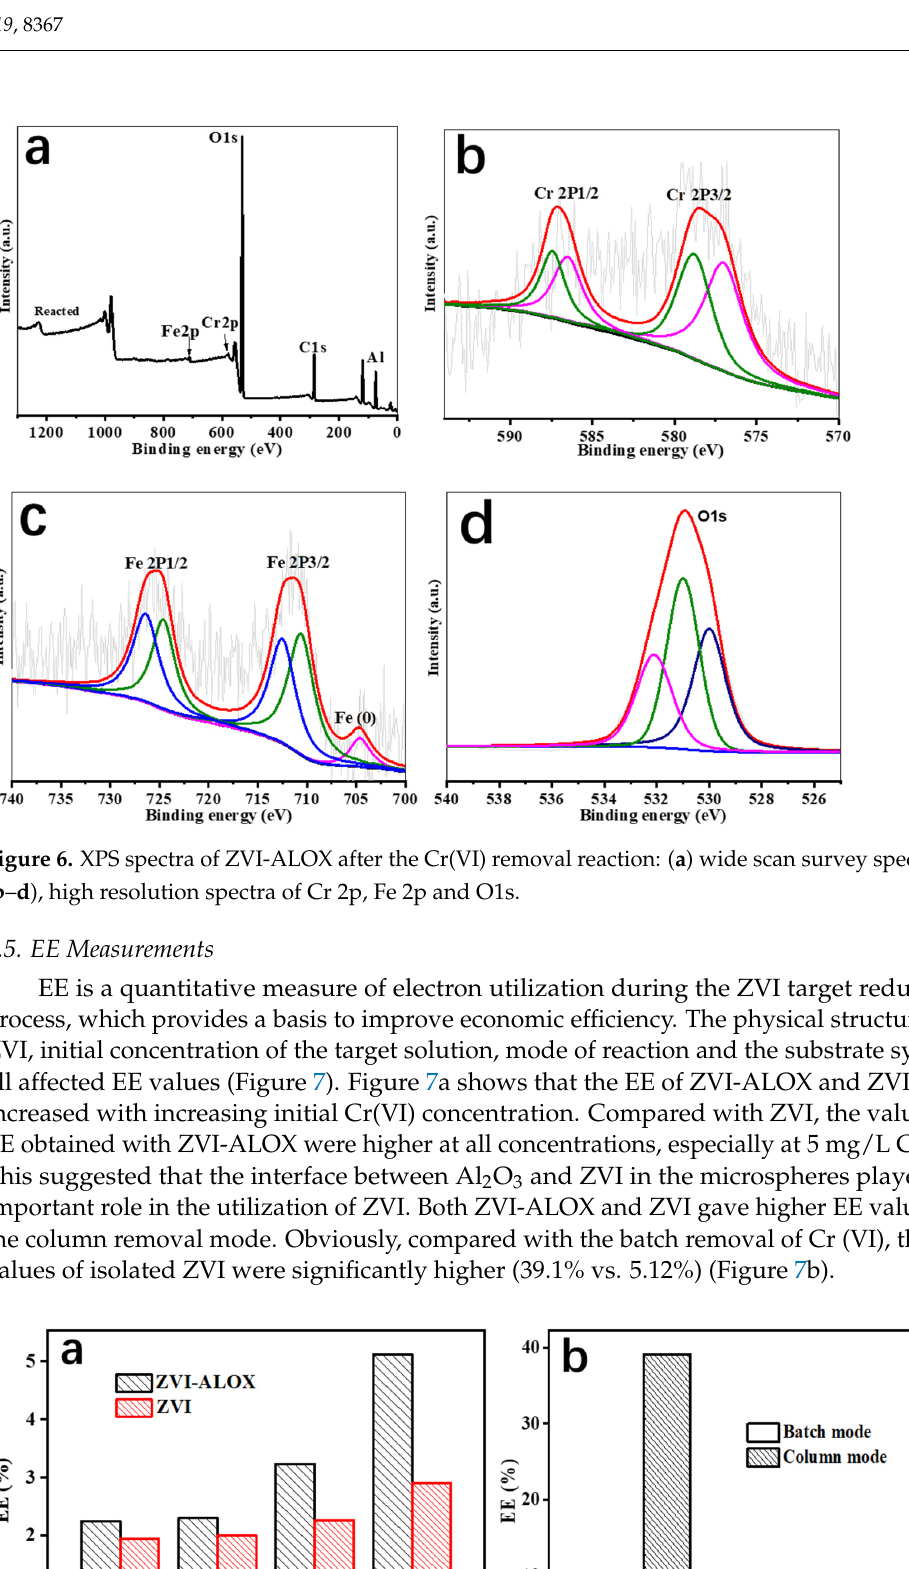
Figure 5. XPS spectra of ZVI-ALOX before the Cr(VI) removal reaction: ( a ) wide scan survey spec- trum; ( b , c ) high resolution spectra of Fe 2p and O1s.